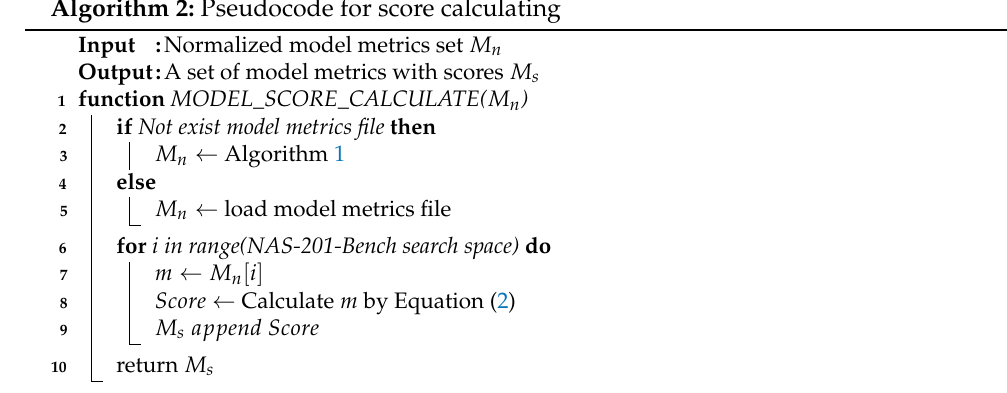
Algorithm 2: Pseudocode for score